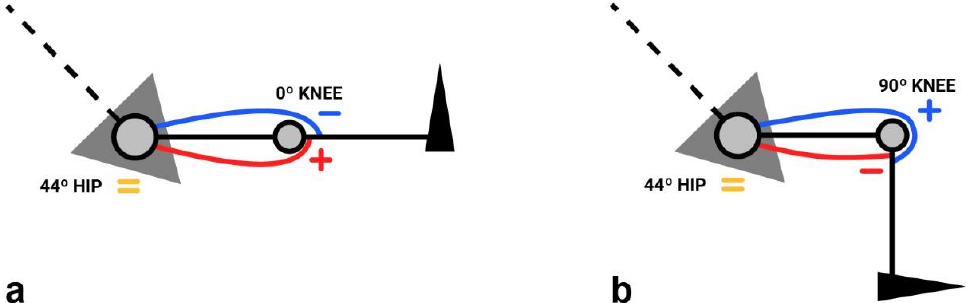
Figure 2. Diagram showing the difference in pretension between the quadriceps and hamstring muscles distally (knee) and equal tension proximally (hip) when the knee is in extension ( a ) and flexion ( b ). The “+” and “ − ” signs can be seen only in the muscle insertion zones. The “=” sign can be seen in the proximal insertion zone of the muscles. “+” means high pretension, “ − ” low pretension and “=” equal pretension. The red lines symbolize the hamstring muscle, and the blue lines symbolize the quadriceps muscle.